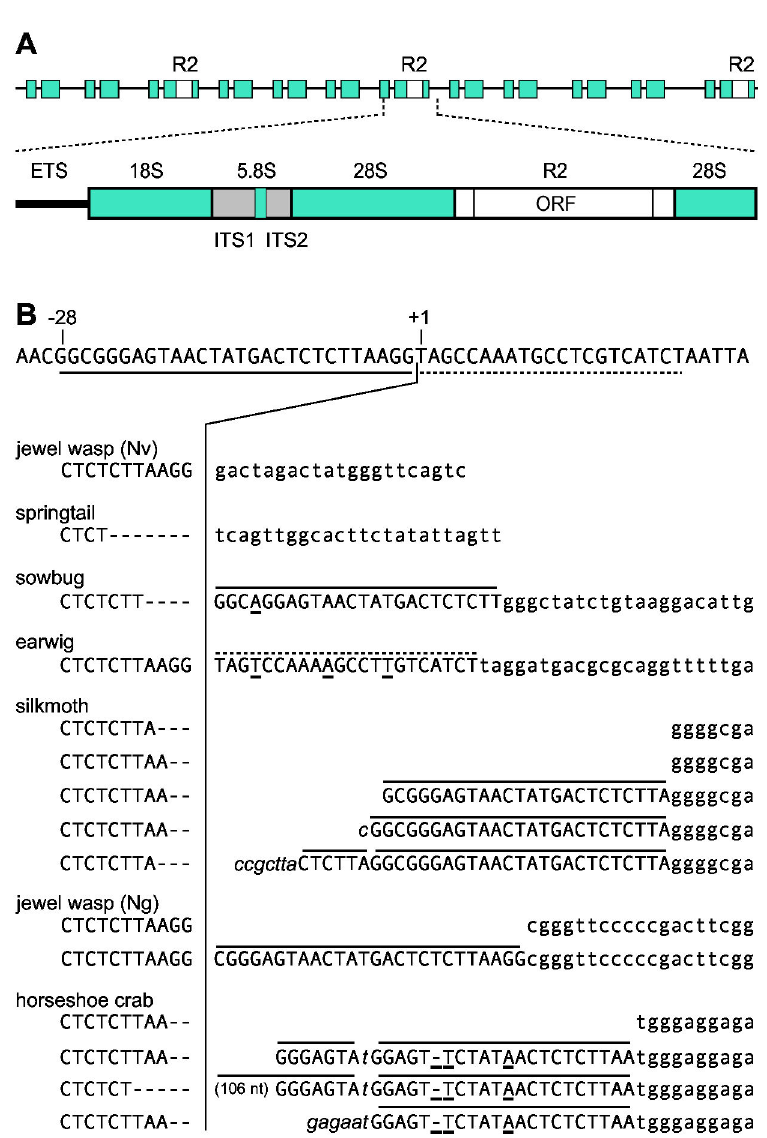
Figure 1. R2 junction variation. (A) A schematic representation of the tandem units in the ribosomal DNA locus with some units containing an R2 insertion. The rRNA transcription unit with external transcribed spacer (ETS), 18S, 5.8S and 28S genes (blue boxes), internal transcribed spacers (ITS, gray boxes), and R2 element (white box) is diagrammed. The single open reading frame (ORF) of R2 is indicated. (B) 28S gene sequence flanking the R2 insertion site with the conserved site of the initial nick indicated as position +1. The 5' junction sequences of the R2 elements obtained from seven arthropods are shown below the 28S sequence. Nucleotides to the left of the vertical line are upstream 28S gene sequences (uppercase). Nucleotides to the right of the vertical line are either R2 (lowercase), have identity to the 28S gene (uppercase, differences underlined), or non-templated additions (italics). One horseshoe crab junction contained an additional 106 nt that are not shown. Overlined sequences correspond to duplications of the 28S gene from upstream (solid) or downstream (dashed) of the target site. doi: 10.1371/journal.pone.0066441.g001 transcript. Surprisingly, the Drosophila R2 ribozymes not only symmetric cleavage/synthesis reactions, termed target primed shared the same secondary structure but also many of the reverse transcription (TPRT), generate new copies. An analysis nucleotides in the catalytic region with the HDV ribozyme of R2s in multiple Drosophila species revealed HDV-like [11,12]. ribozymes at the 5' end of each element responsible for cleaving the 5' end of the R2 sequences from the 28S/R2 co-